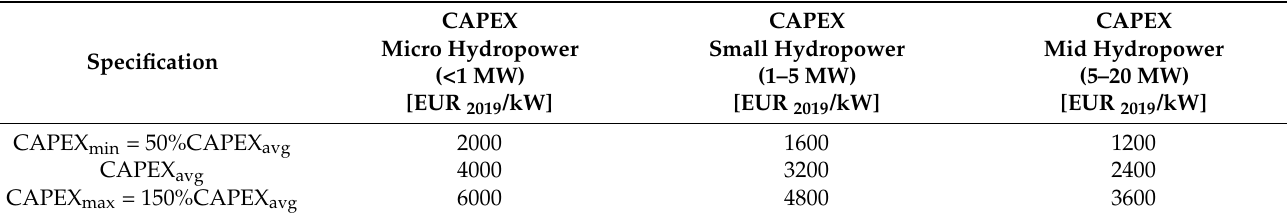
Table 4. Unit operational expenditures CAPEX calculated for the analyses.